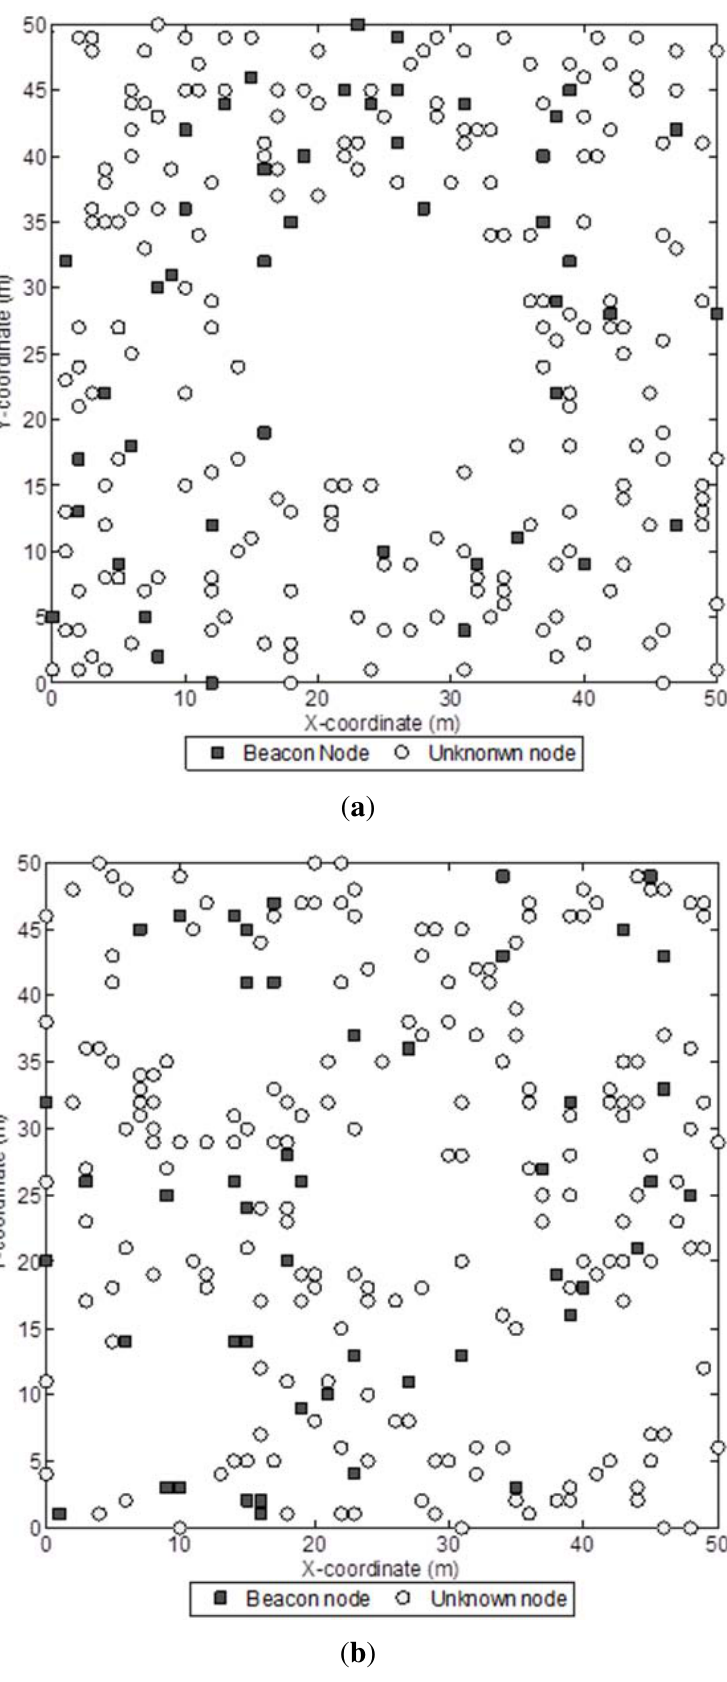
Figure 8. Sample networks with coverage holes (250 sensor nodes and 50 beacon nodes): ( a ) 1 hole; ( b ) 5